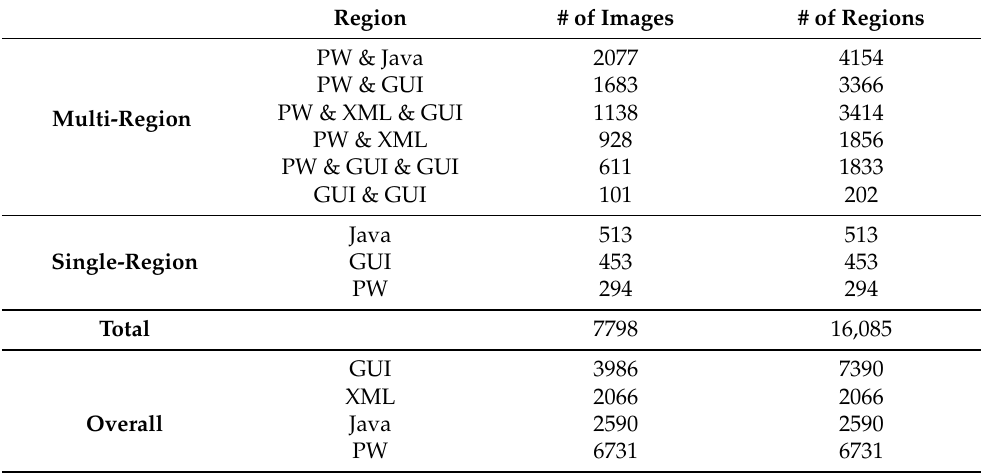
Table 1. Statistics of the dataset with respect to the annotated regions in terms of a single-region system (exactly one region in an image) a multi-region system (at least two regions in an image). Region # of Images # of Regions PW & Java 2077 4154 PW & GUI 1683 3366 Multi-Region PW & XML & GUI 1138 3414 PW & XML 928 1856 PW & GUI & GUI 611 1833 GUI & GUI 101 202 Java Single-Region GUI 453